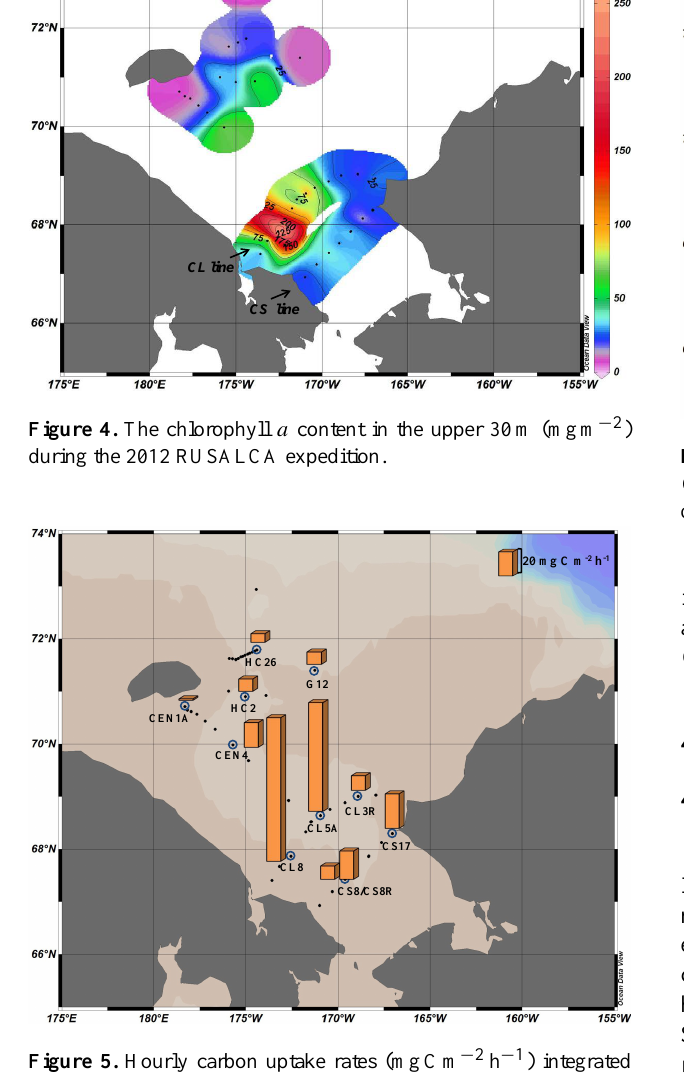
Figure 5. Hourly carbon uptake rates (mgCm − 2 h − 1 ) integrated from the surface to 1% light depth during the 2012 RUSALCA ex- pedition.